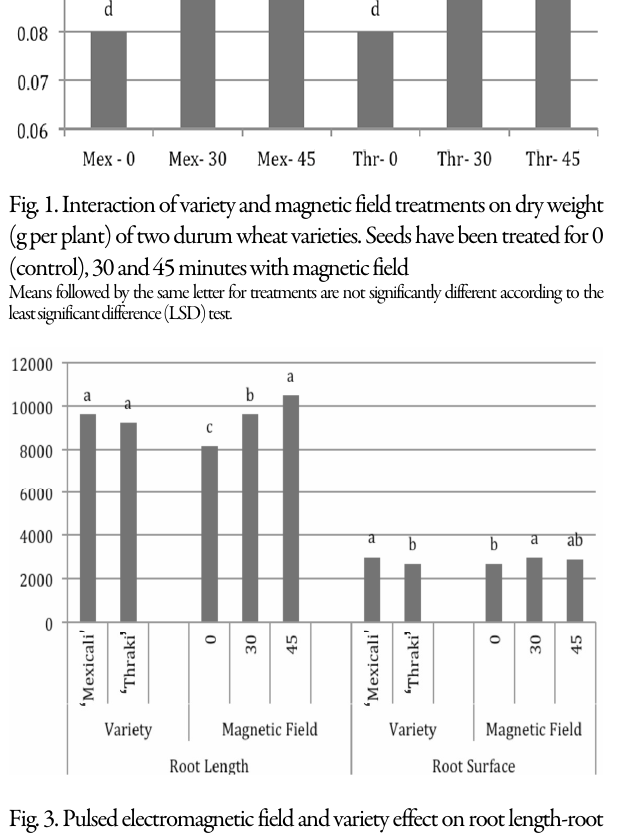
Fig. 3. Pulsed electromagnetic field and variety effect on root length-root surface (mm per plant) of two durum wheat varieties. Seeds have been treated for 0 (control), 30 and 45 minutes with magnetic field Means followed by the same letter for treatments are not significantly different according to the least significant difference (LSD) test.